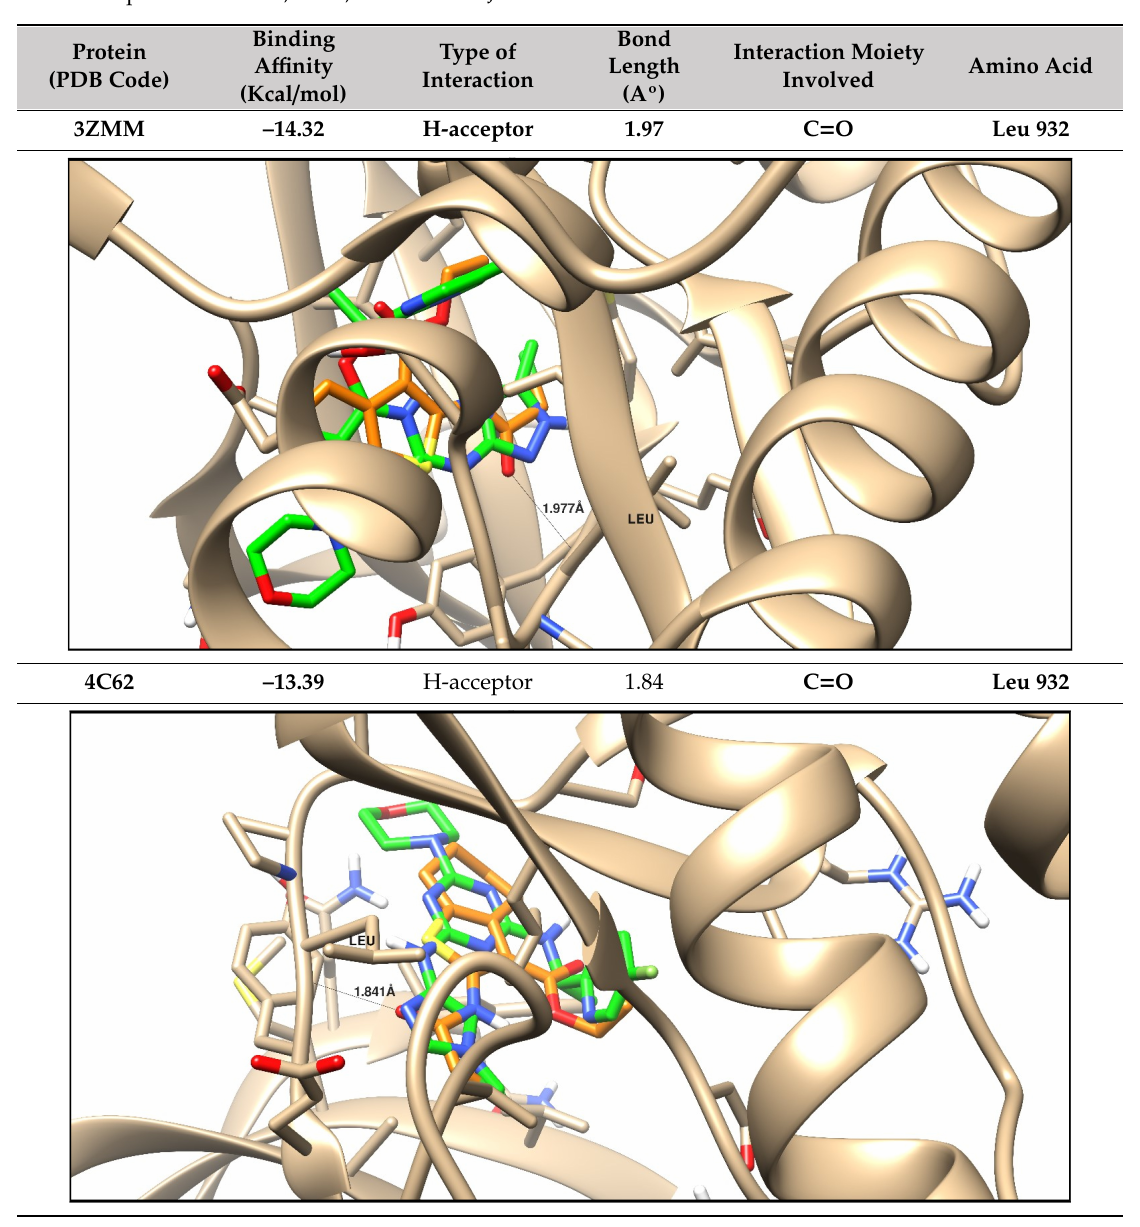
Table 2. Analysis of ligand-receptor interactions with binding energies of docked compound 4 inside three proteins 3ZMM , 4C62 , and 5AEP as Jak2